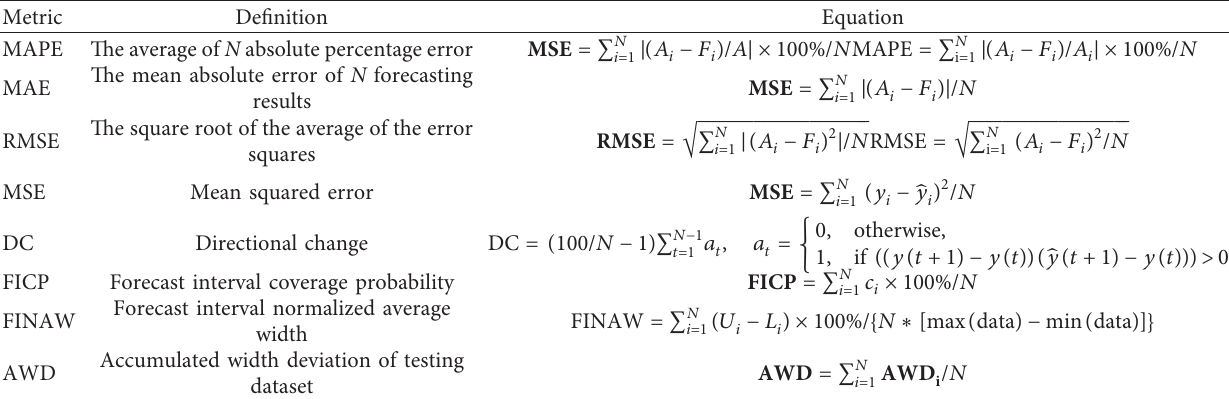
Table 4: The indexes for evaluating the prediction ability.